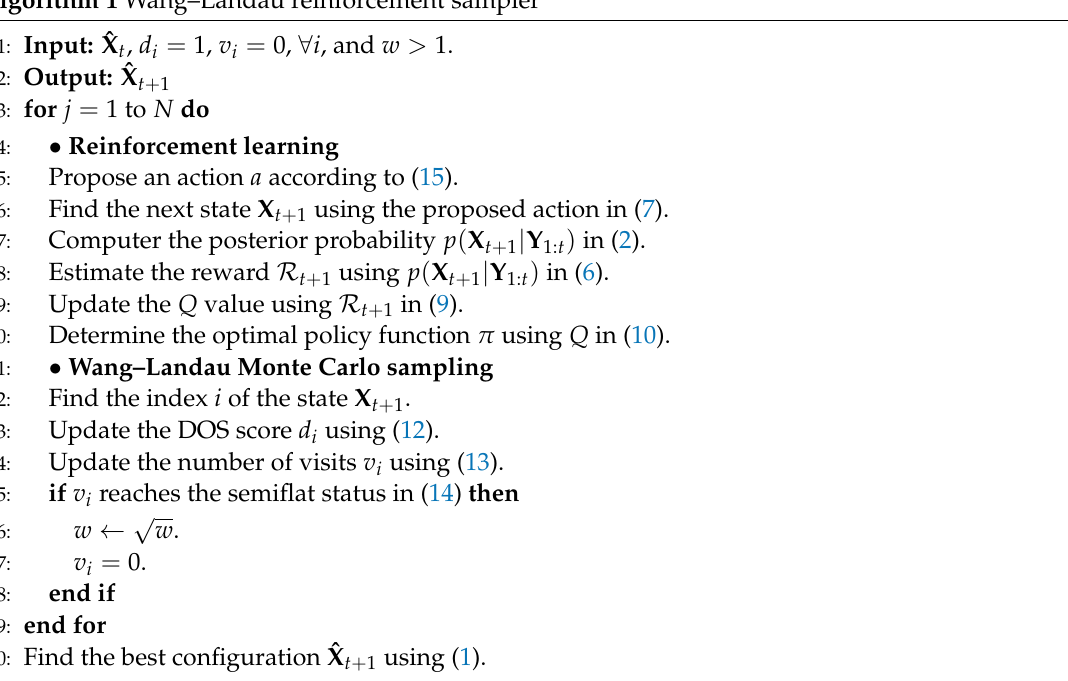
Algorithm 1 Wang–Landau reinforcement